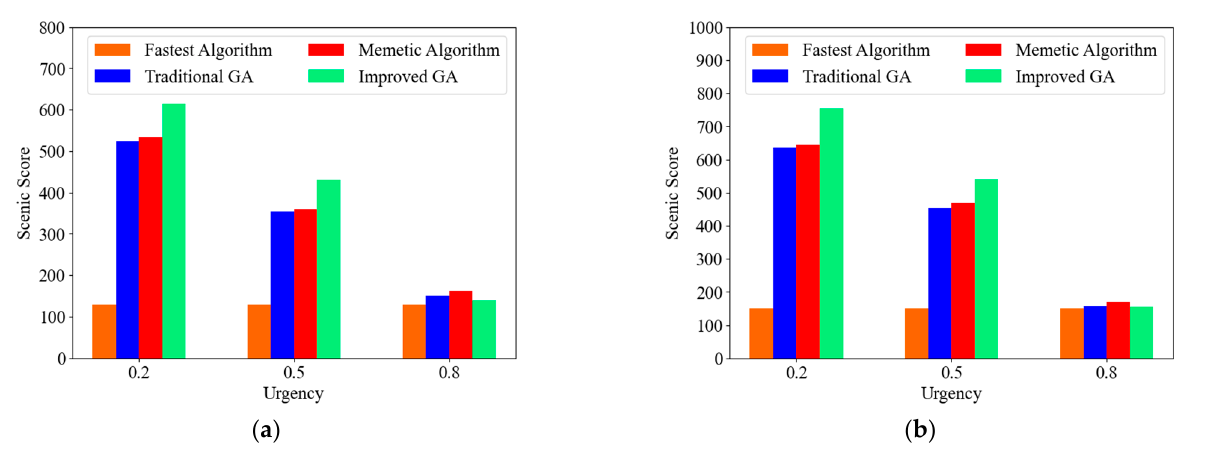
Figure 12. Comparison of scenic score under different urgencies. ( a ) Xi’an; ( b ) Wuhan.